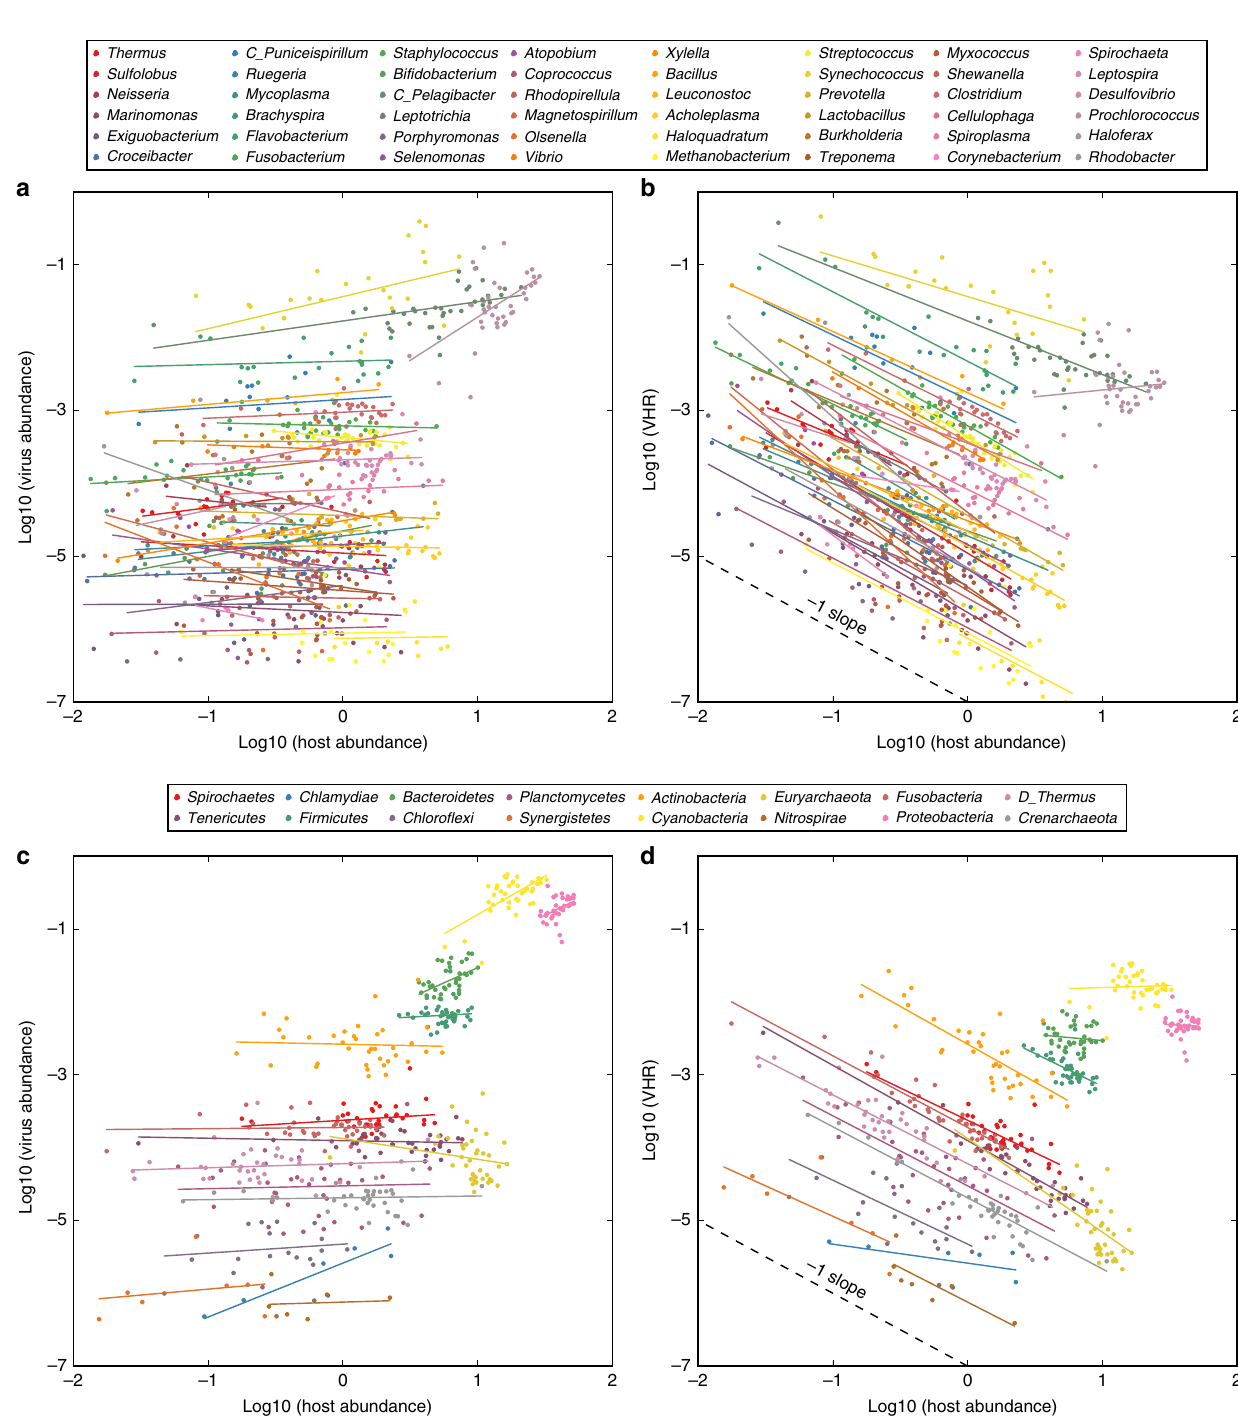
Fig. 1 Relationships between virus abundances, virus – host ratios (VHRs), and host abundances. a Genus-level relationships, virus vs. host abundances. b Genus-level relationships, VHRs vs. host abundances. c Phylum-level relationships, virus vs. host abundances. d Phylum-level relationships, VHRs vs. host abundances. Panels b and d are replotted from ref. 1 . The absence of a relationship between original, untransformed virus and host abundances (see panels a and c ) should appear as a − 1 slope when comparing VHR to host abundances (see panels b and d ). A − 1 slope is shown as a guide to readers in